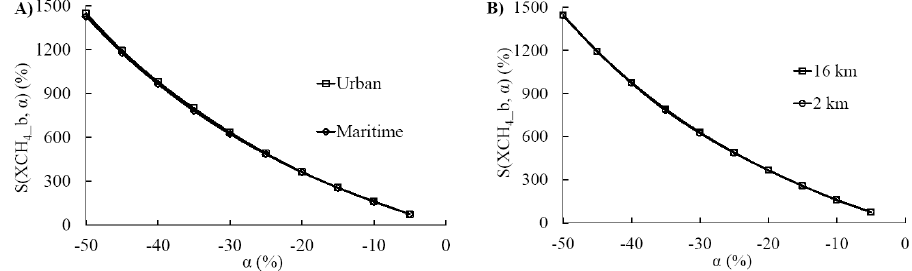
Figure 10. Column retrieval error ( S (XCH 4_b , α )) versus α for XCH 4_b of plume case k = 1 for ( A ) different aerosol type, ( B ) different visibility.